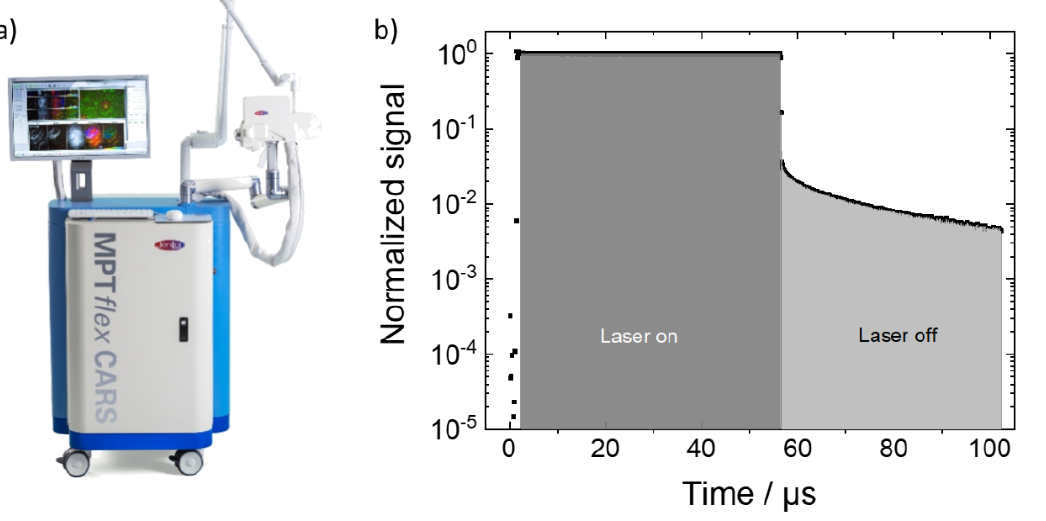
Figure 1. ( a ) Multiphoton imaging system which was modified to incorporate additional PLIM capability as described in the text. ( b ) Temporal dependence of the recorded signals during the pixel dwell time during which the laser illumination was first on (“laser-on”) and then switched off (“laser-off times”). During the “laser-on time” fluorescence and phosphoresce are generated. The fluorescence quickly fades after the laser illumination is stopped and the slower decaying phosphoresce can be detected background free. The shaded areas indicate the time segments which were summed to yield the fluorescence and phosphoresce